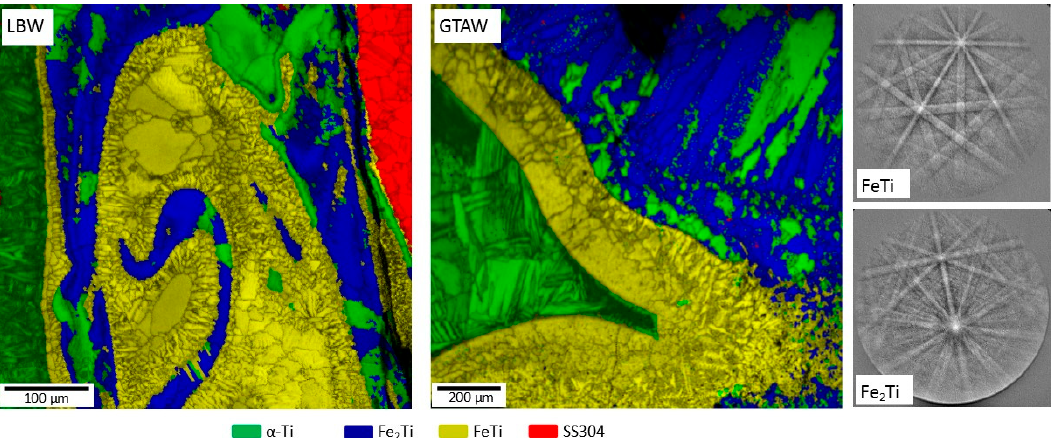
Figure 8. Electron backscattered diffraction (EBSD) phase map with image quality (IQ) overlay showing intermetallics present in the CPTi/SS304 weld zone. Scan step size is 1.5 µm. The EBSD patterns of FeTi and Fe 2 Ti are also shown.